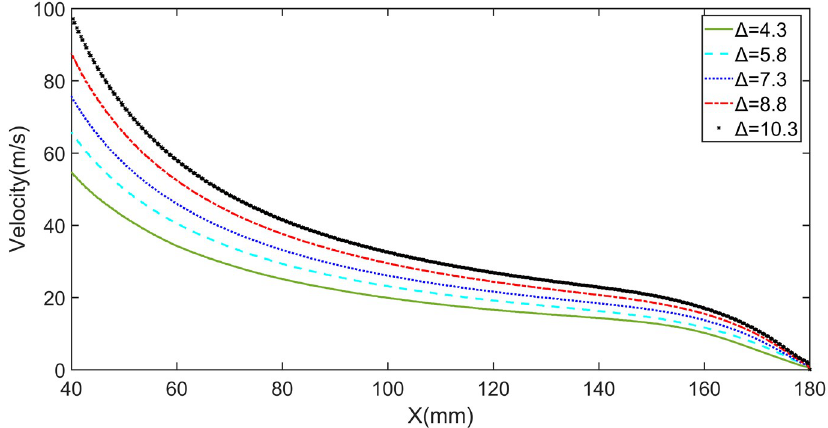
Figure 10. Gas velocity along the x -axis with different Δ when the gas phase developed